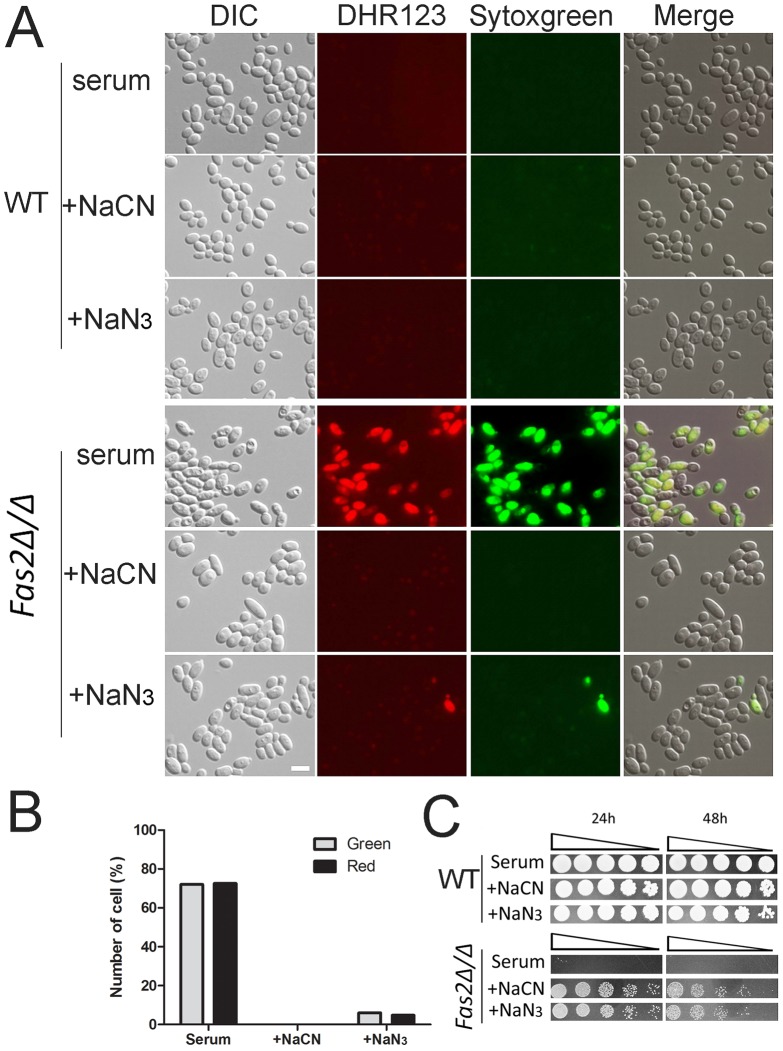
Cell death results from overproduction of mitochondrial ROS.A, Accumulation of mitochondrial ROS in Fas2Δ/Δ yeast cells after serum treatment. WT and Fas2Δ/Δ yeast cells were treated with 50% serum with or without 1 mM sodium cyanide (NaCN) or 2.5 mM sodium azide (NaN2) for 24 h at 30°C. Yeast cells were stained with dihydrorhodamine 123 and Sytogreen to visualize ROS and dead cells, respectively. Scale bar: 5 µm. B, Accumulation of ROS coincided with the death of Fas2Δ/Δ yeast cells. The numbers of red (ROS positive) and green (Sytogreen positive) were assessed for Fas2Δ/Δ yeast cells treated for 12 h with serum in the presence or absence of cyanide or azide. C, Inhibition of mitochondrial respiration rescued death of Fas2Δ/Δ yeast cells. Spot assay on YPDT40 of yeast cells incubated with serum in the presence or absence of 1 mM sodium cyanide or 2.5 mM sodium azide. Experiments were performed three times with reproducible results.